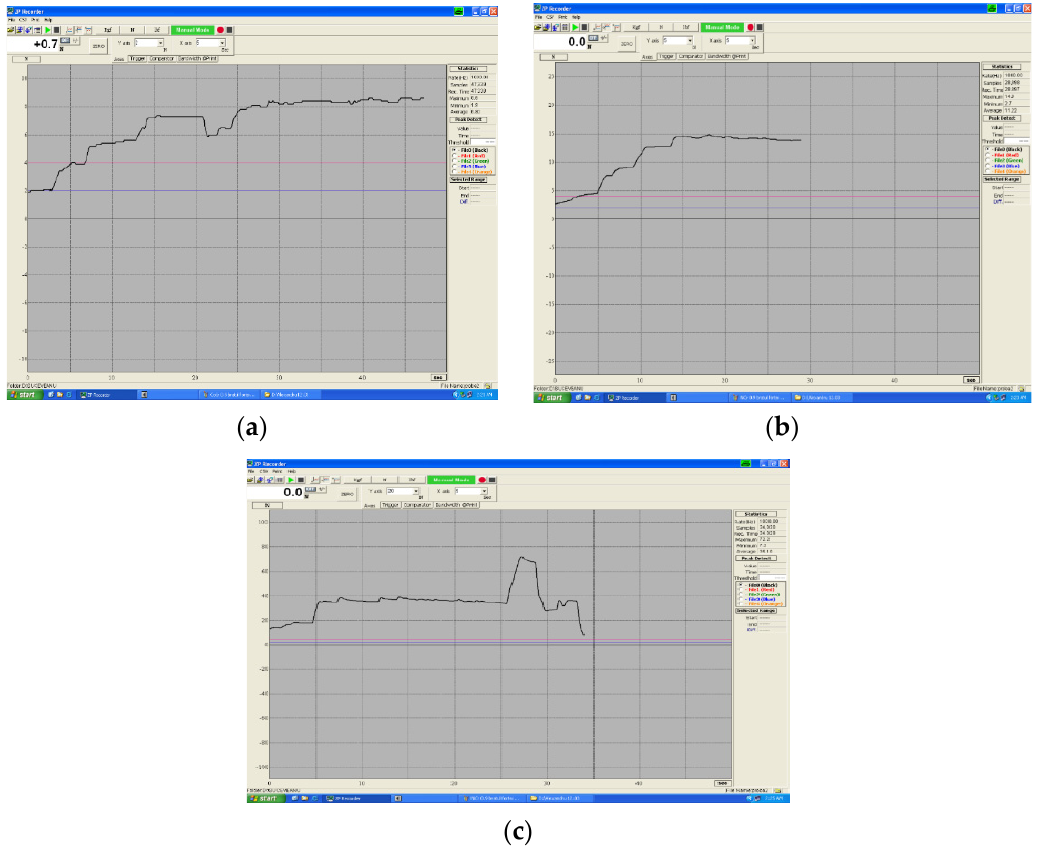
Figure 9. ( a – c ) Evolution of Ni-Cr arc deformations, diameter 0.9 mm. For the 0.9 mm Cr Co wire, the results are listed in Table 4. Table 4. Results for Co-Cr 0.9 mm arches.